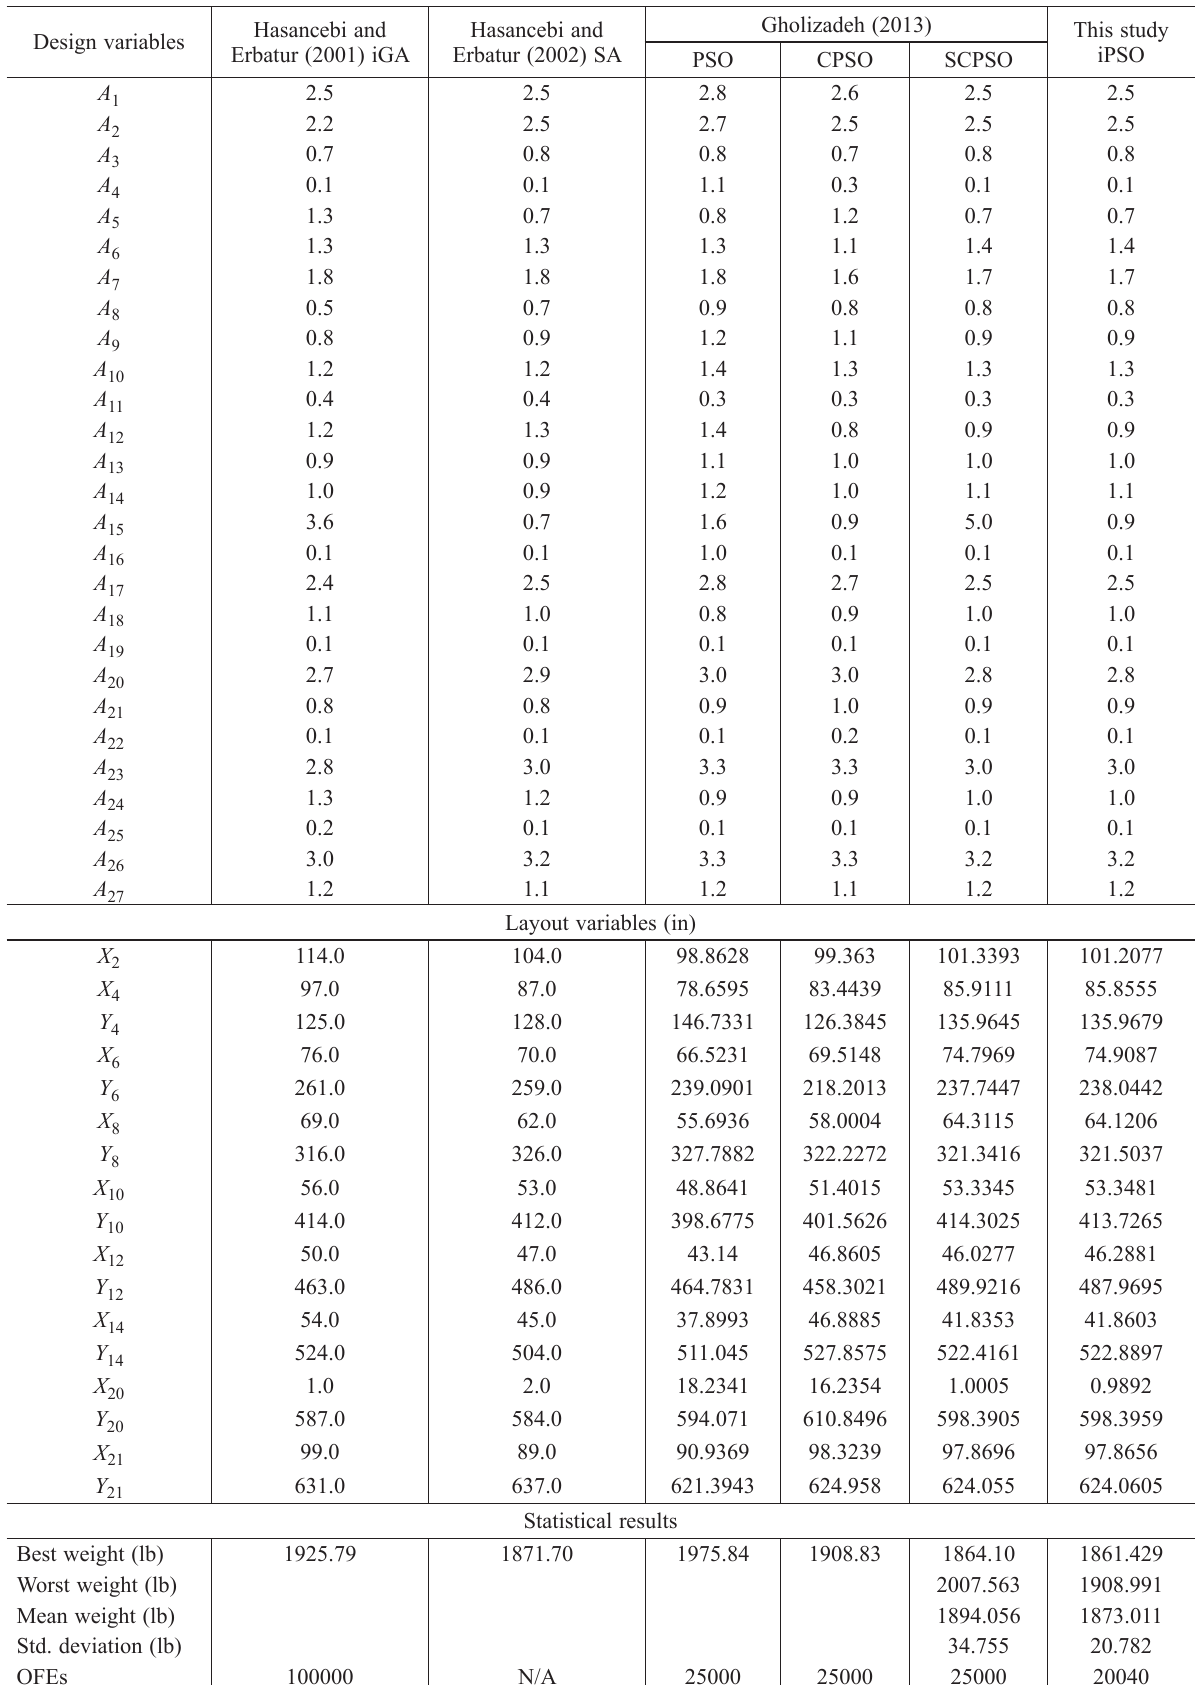
Table 13. Comparison of the iPSO optimization results with the literature for the planar 47-bar truss